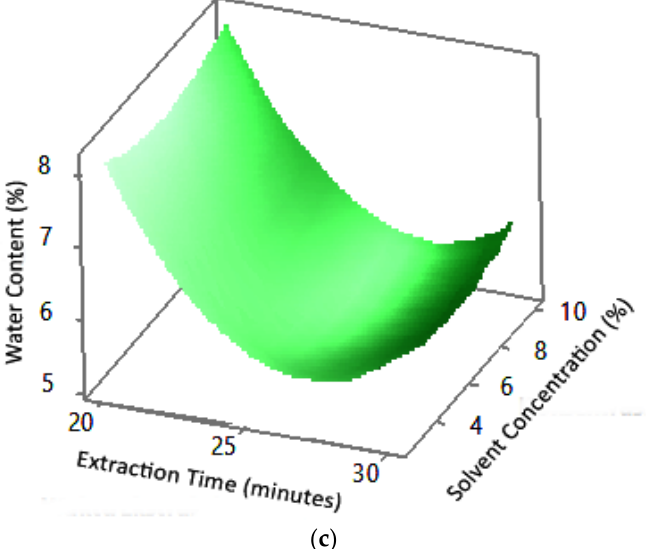
Figure 9. Effect of extraction time and solvent concentration on water content at microwave powers: ( a ) 180 W, ( b ) 300 W, and ( c ) 450 W.